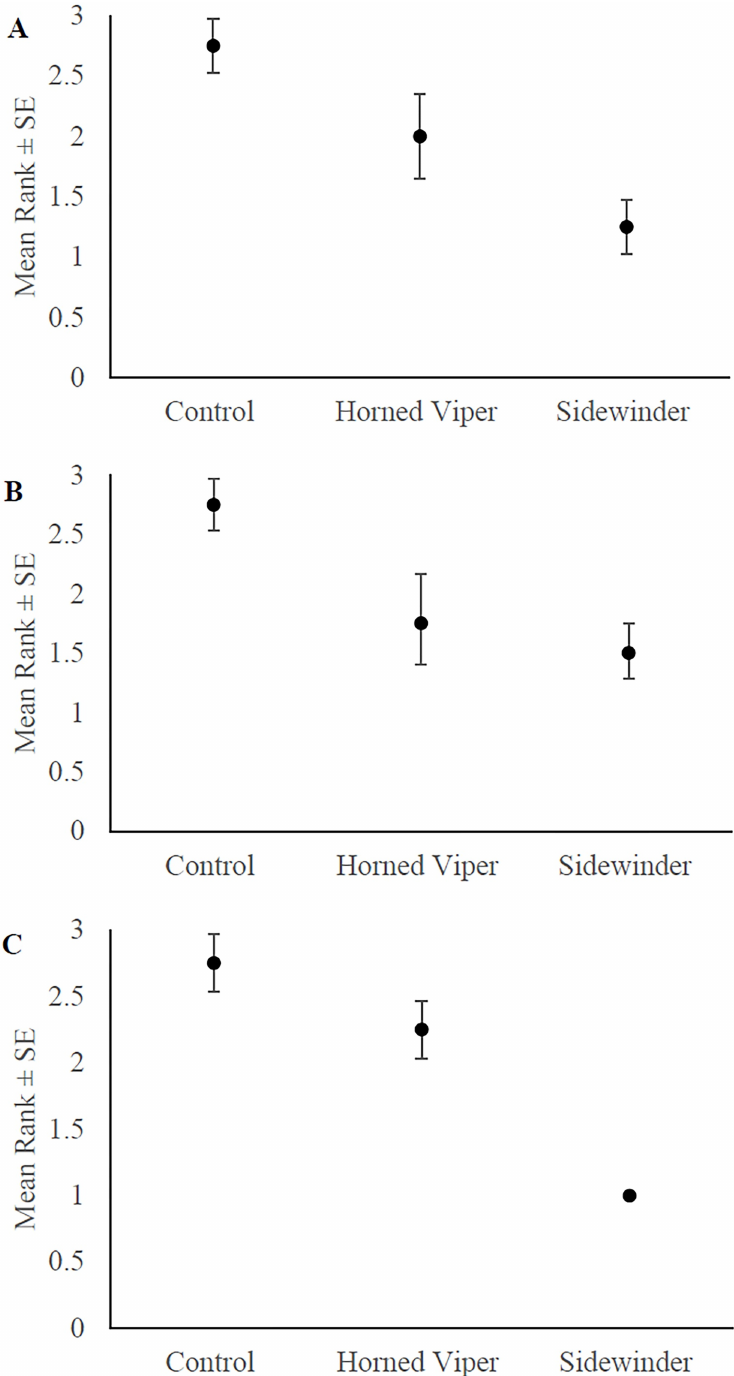
Fig 1. Rodent assessment of risk, presented in mean ranks (±SE) produced by the Friedman’s tests of concordance based on mean GUD per snake treatment overall, before-exposure and after exposure. The greater the risk the lower the rank (from 1–3). (A) Overall risk assessment (combined pre- and post-exposure). (B) Risk assessment at first encounter showing no clear difference between the two types of snakes suggestive of the fact that rodents ranked their known snake as an equal or greater risk to the novel species. (C) risk assessment post-exposure.